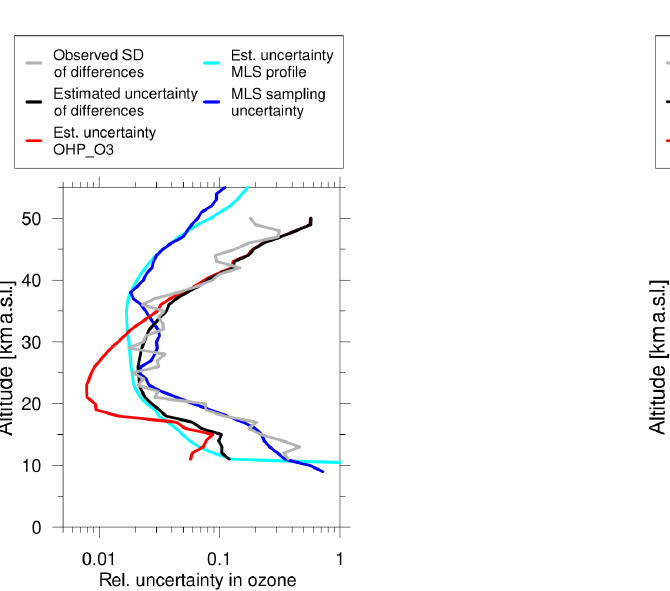
Figure 12. Vertical profiles of estimated relative ozone measure- ment uncertainties for individual MLS profiles (Froidevaux et al., 2008) from the MLS data files (cyan line), and MLS spatial vari- ation/sampling uncertainty estimated from all profiles in the co- location box (blue line). LiO 3 S measurement uncertainty is indi- cated by the red line. Estimated combined uncertainty for the rela- tive ozone difference (MLS minus LiO 3 S) based on MLS individual profile uncertainty is given by the black line. The grey line gives the observed standard deviation of the relative ozone differences be- tween MLS and LiO 3 S during LAVANDE.